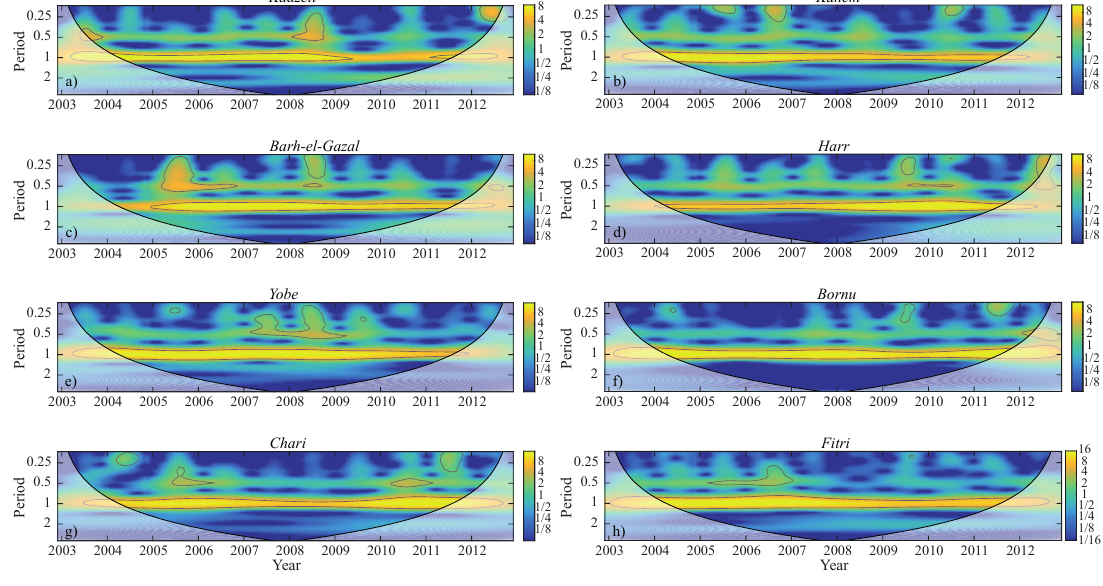
Figure 7. Same as Figure 3 for the TRMM rain